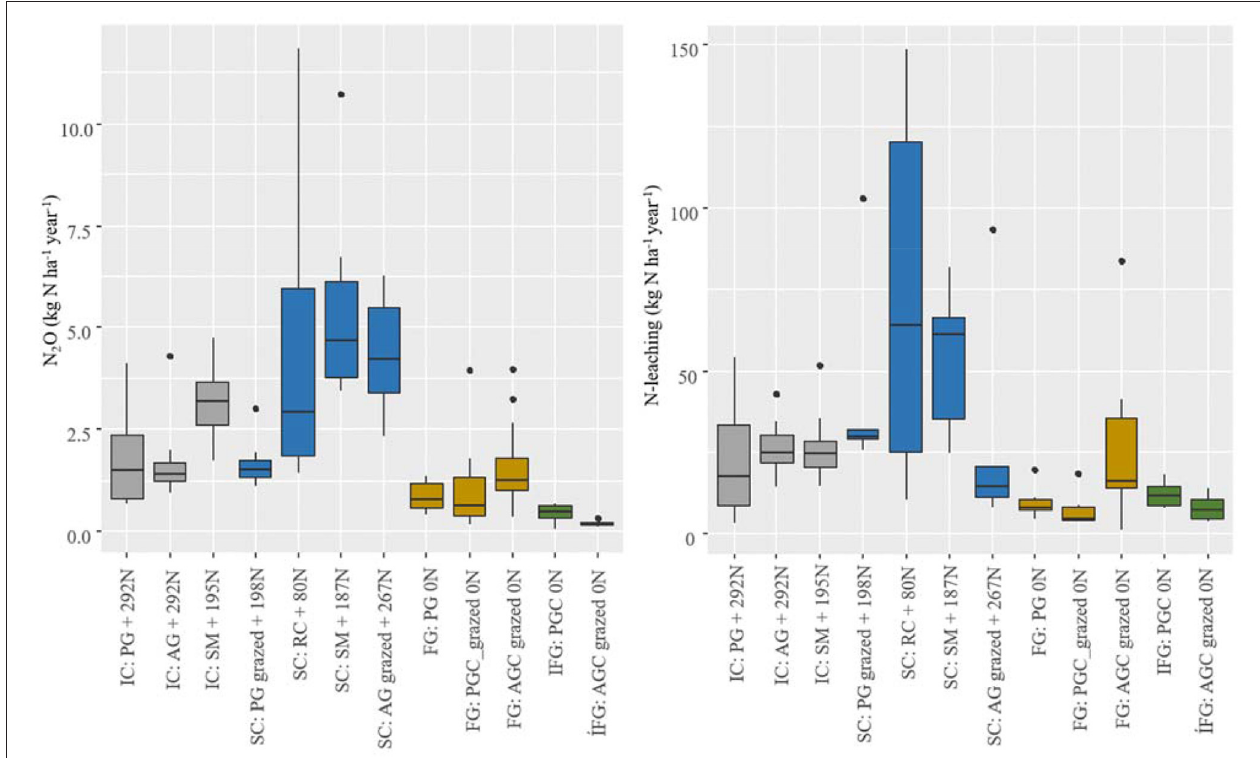
FIGURE 2 | Box-plots present the measured accumulated N 2 O emissions and N-leaching to ground or drainage water losses across the different farm types (IC, intensive-confinement; SC, semi-confinement; FG, full-grazing; IFG, integrated full-grazing) and forage crops (PG, permanent grassland; AG, arable grass; RC, red-clover-grass; AGC, arable grass-clover; SM, silage maize; PGC, permanent grass-clover; AGC, arable grass-clover). The amount of N applied (kg N ha − 1 ) by mineral fertilizer and slurry is given in the figure legend. N-losses of two experimental years are shown. The box represents the 25th and 75th percentile. The black line in the box is the median. The whiskers represent the minimum and maximum values. Dots are outliers.